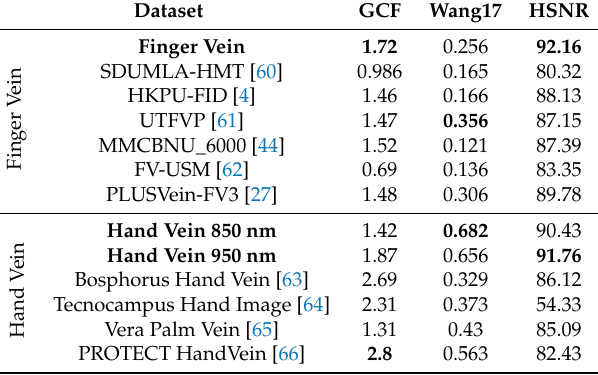
Table 1. Image quality assessment results for the proposed datasets (bold face) and several available finger- and hand vein datasets. Best results per quality metric and modality are highlighted bold face